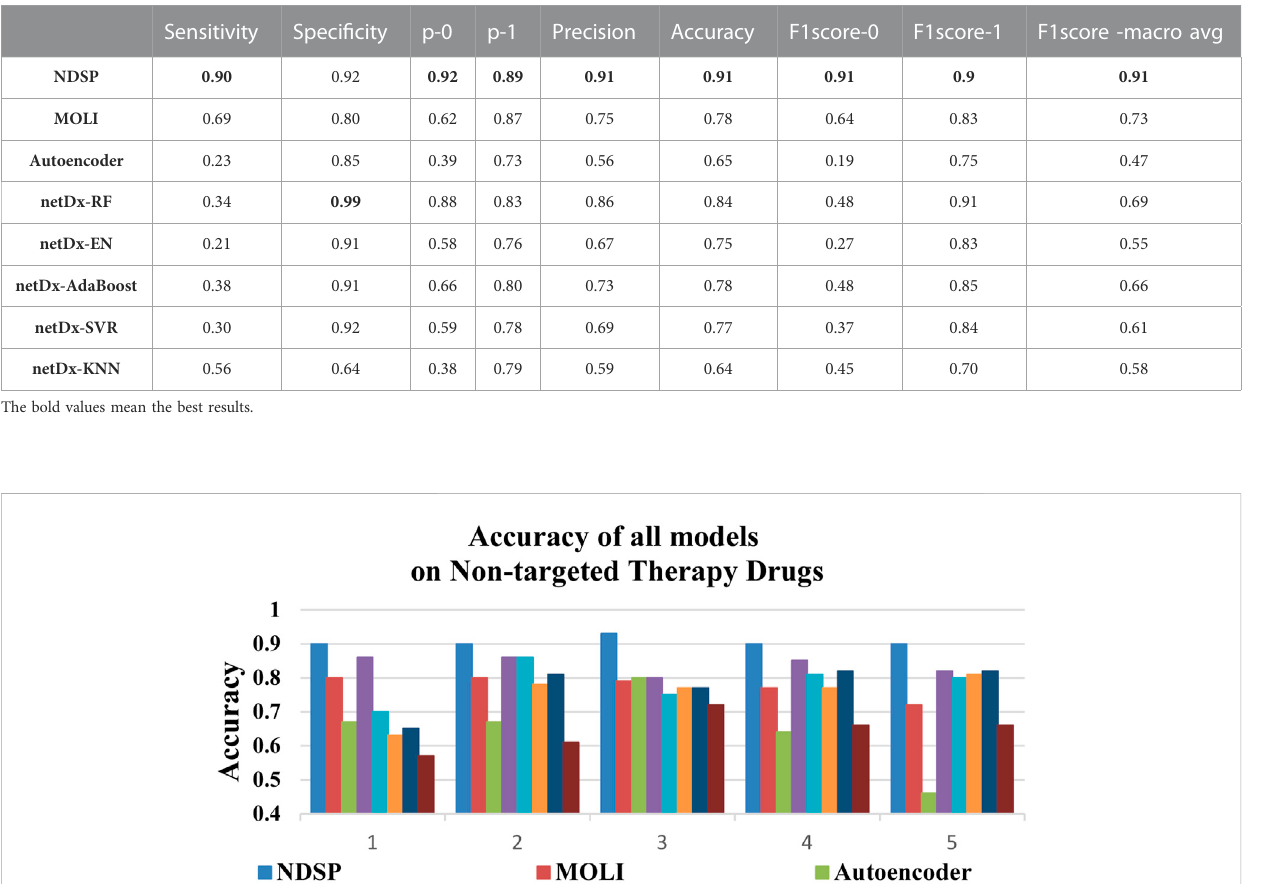
TABLE 2 Index mean of 8 models on non-targeted therapy drugs.